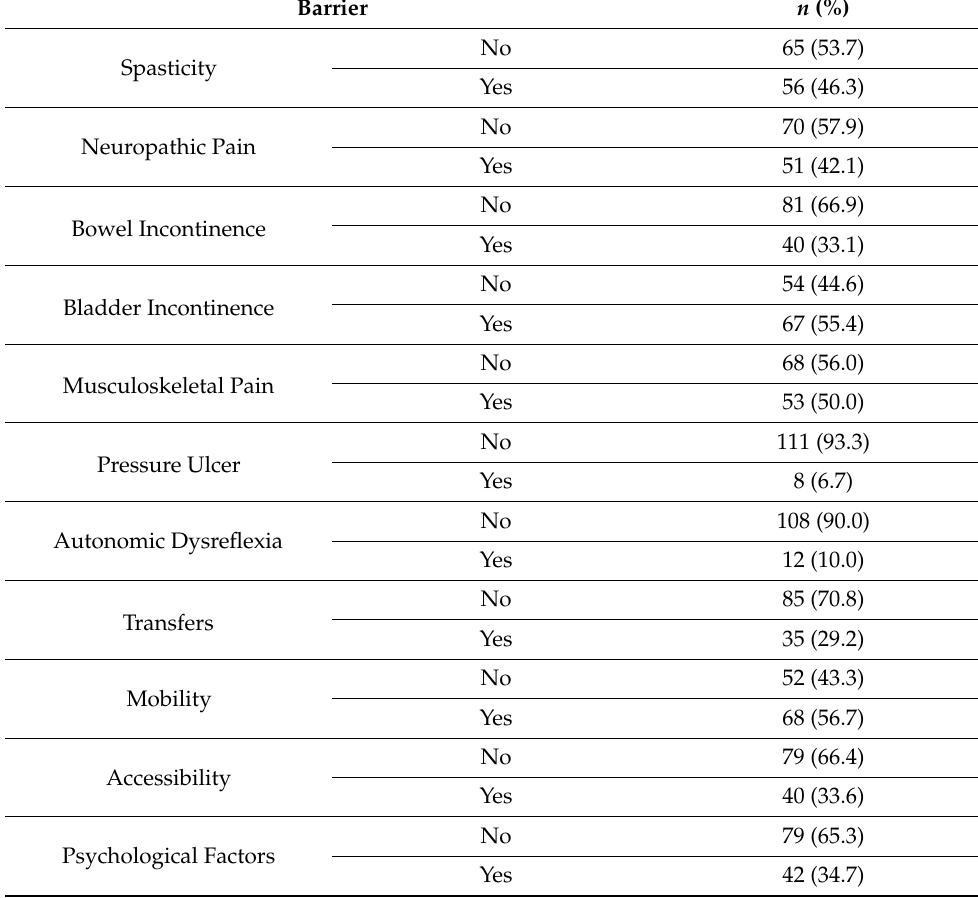
Table 2. Perceived clinical barriers to employment in a Saudi cohort with spinal cord